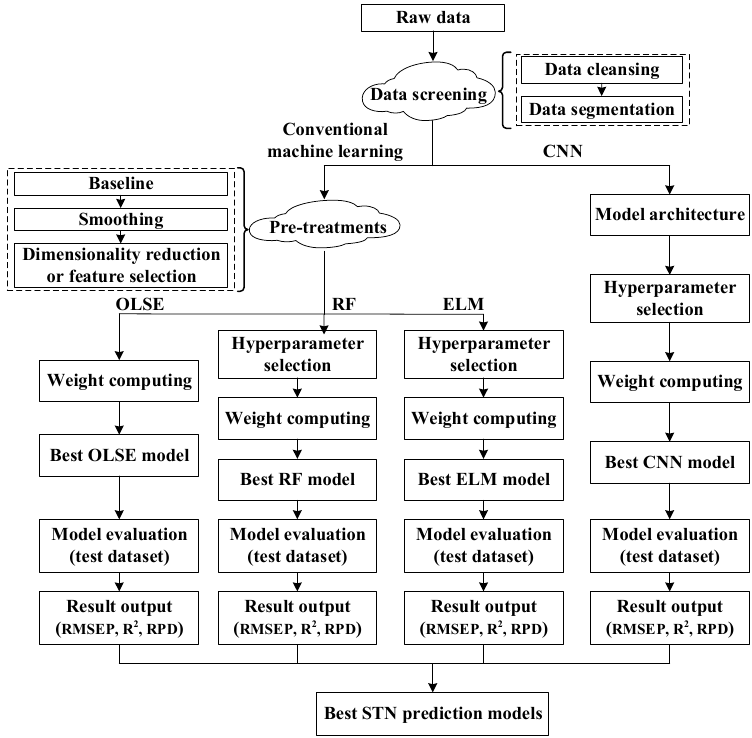
Figure 1. Workflow for soil total nitrogen (STN) prediction model based on visible ‐ near ‐ infrared spectrum (Vis ‐ NIRS).